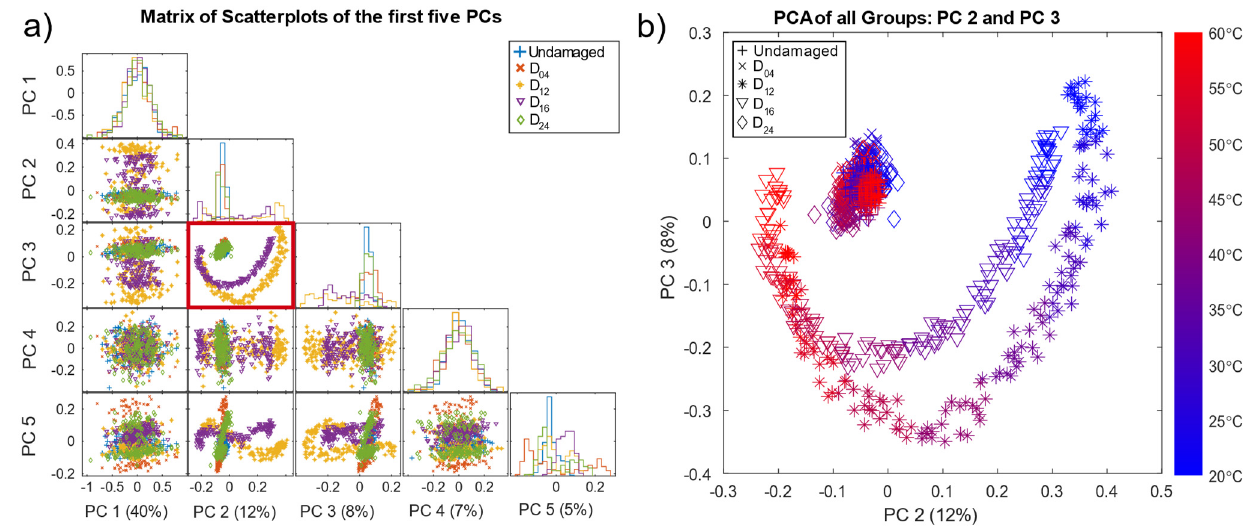
Figure 5. ( a ) Matrix of the first five PCs of the PCA on the pre-processed data (undamaged plate and all simulated damage locations) with their histograms on the diagonal and the variance explained by each PC given as a percentage in brackets. The red box indicating the scatterplot of PC 2 and PC 3 is also shown in ( b ), where the data points are additionally coloured by their corresponding temperature.